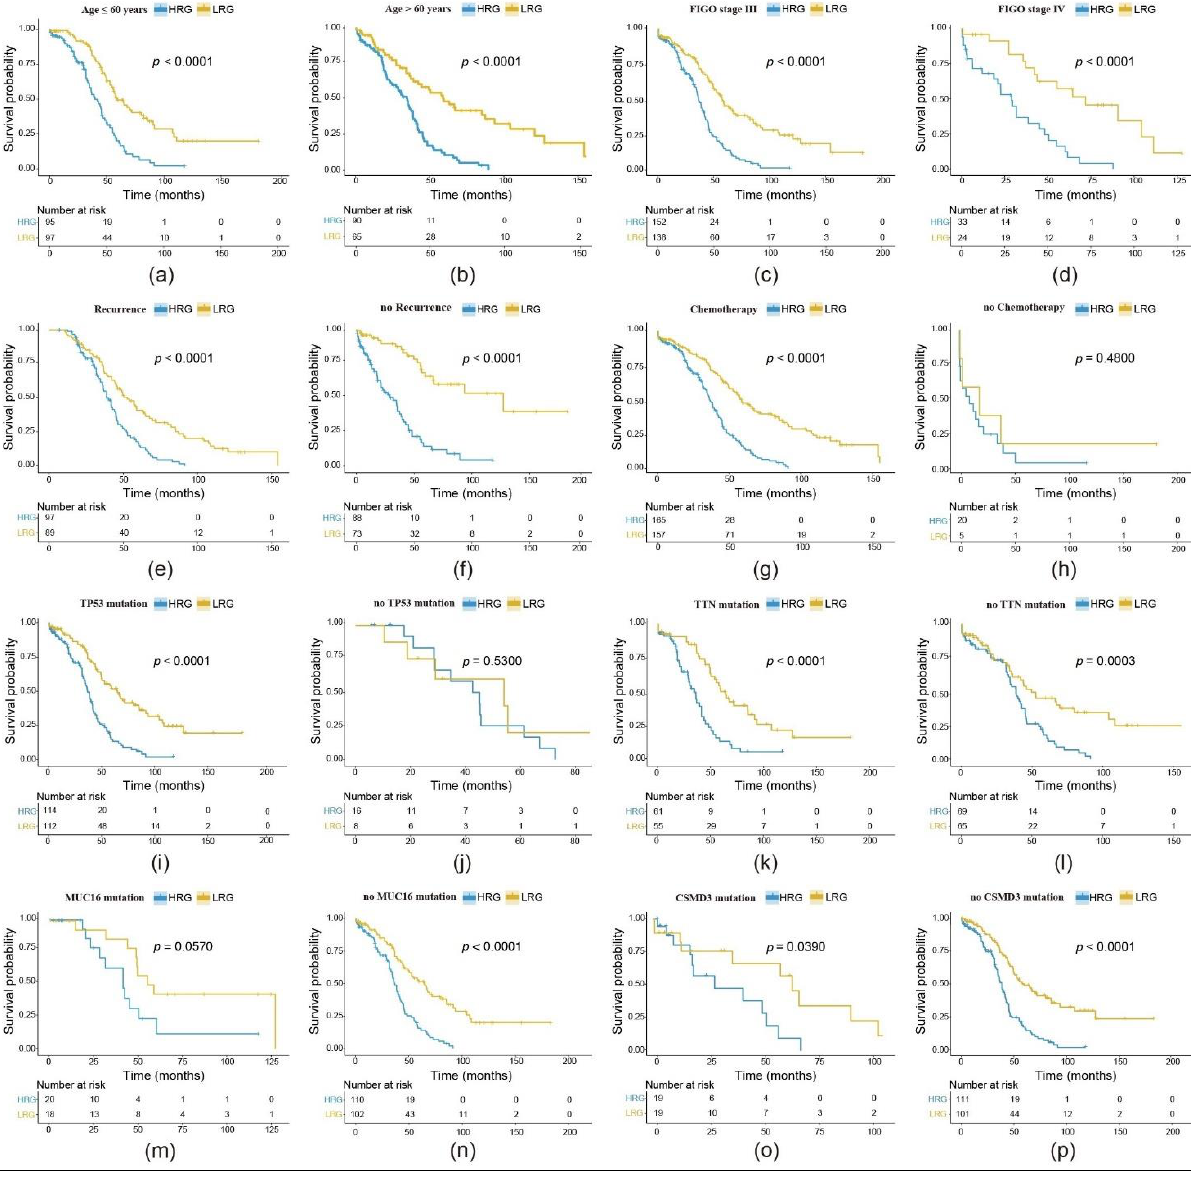
Figure 3. Evaluation of the 11-gene risk model in different subgroups with OS KM curves comparing the high-risk group (HRG) and the low-risk group (LRG): ( a – h ) Subgroups with different clinical features; ( i – p ) subgroups with different mutations.